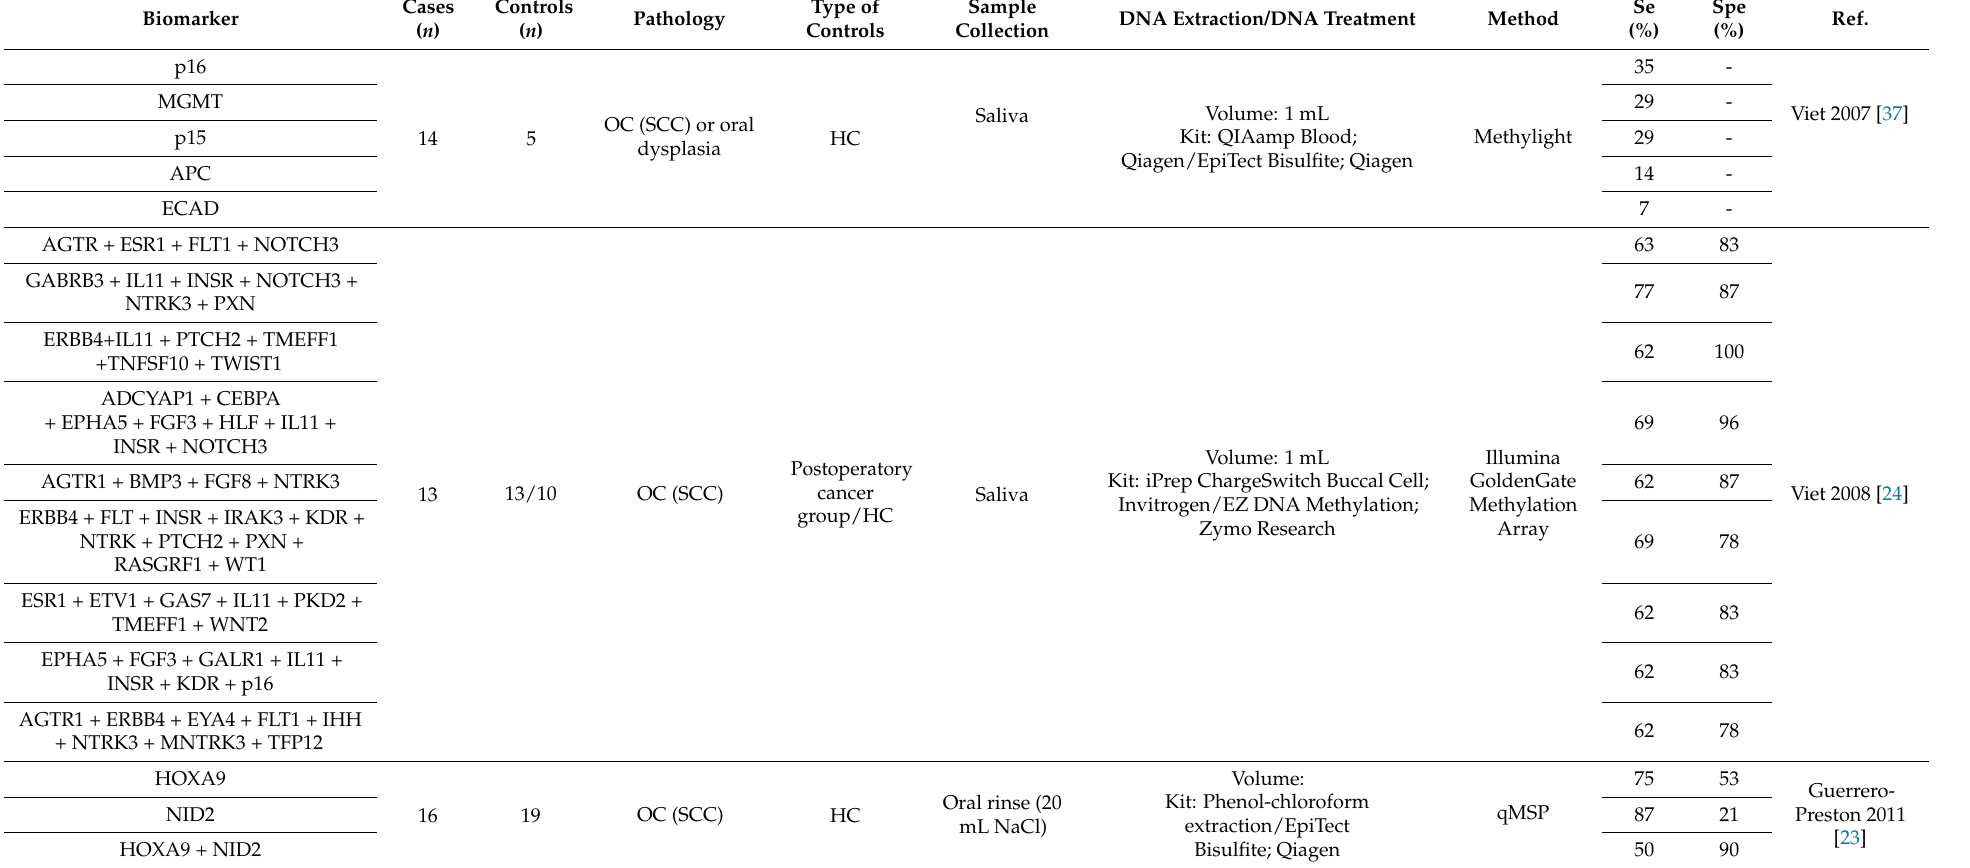
Table 1. Characteristics of the salivary DNA methylation studies on oral cancer and